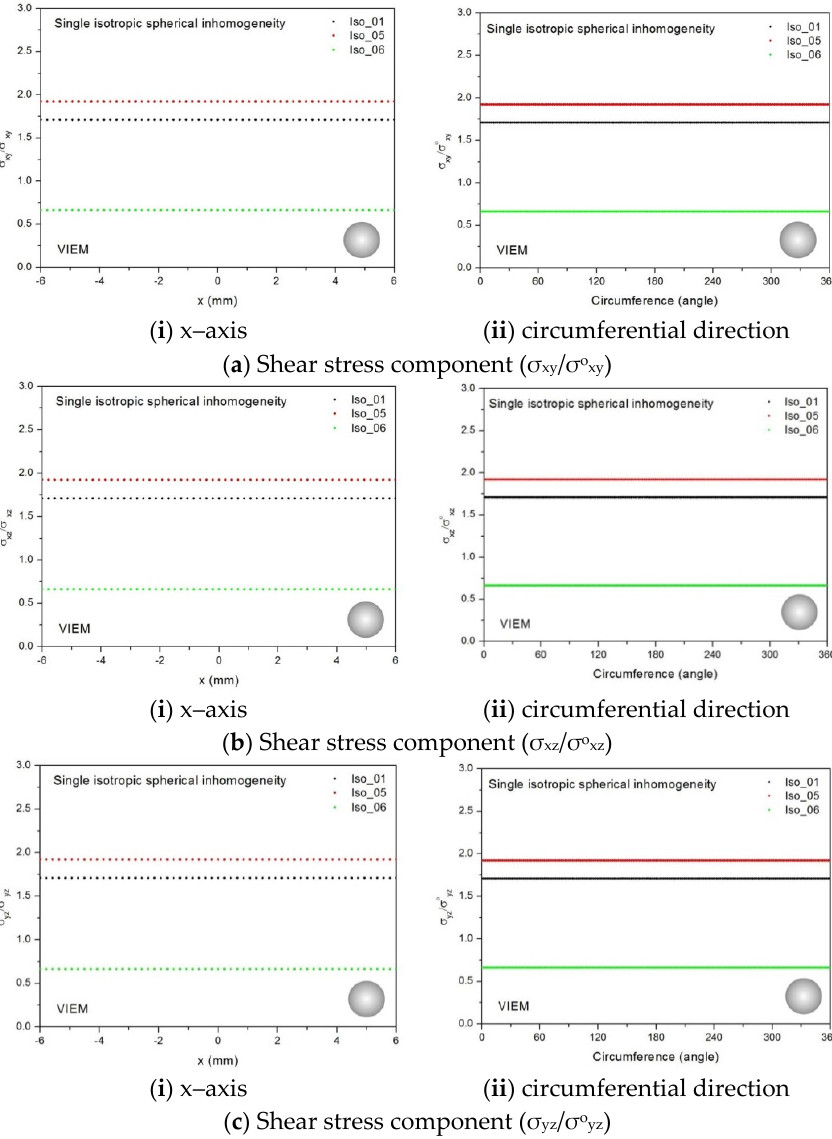
Figure 22. VIEM results for the normalized shear stress components ( a ) σ xy / σ oxy , ( b ) σ xz / σ oxz and ( c ) σ yz / σ oyz along ( i ) the x–axis inside and ( ii ) the circumferential direction of the isotropic spherical inclusions (Iso_01, Iso_05 and Iso_06) with a radius of 6 mm under remote shear loading ( σ oxy , σ oxz and σ oyz ). Table 18. Normalized shear stress components ( σ xy / σ oxy , σ xz / σ oxz and σ yz / σ oyz ) within the isotropic spherical inclusion due to remote shear loading ( σ oxy , σ oxz and σ oyz ).